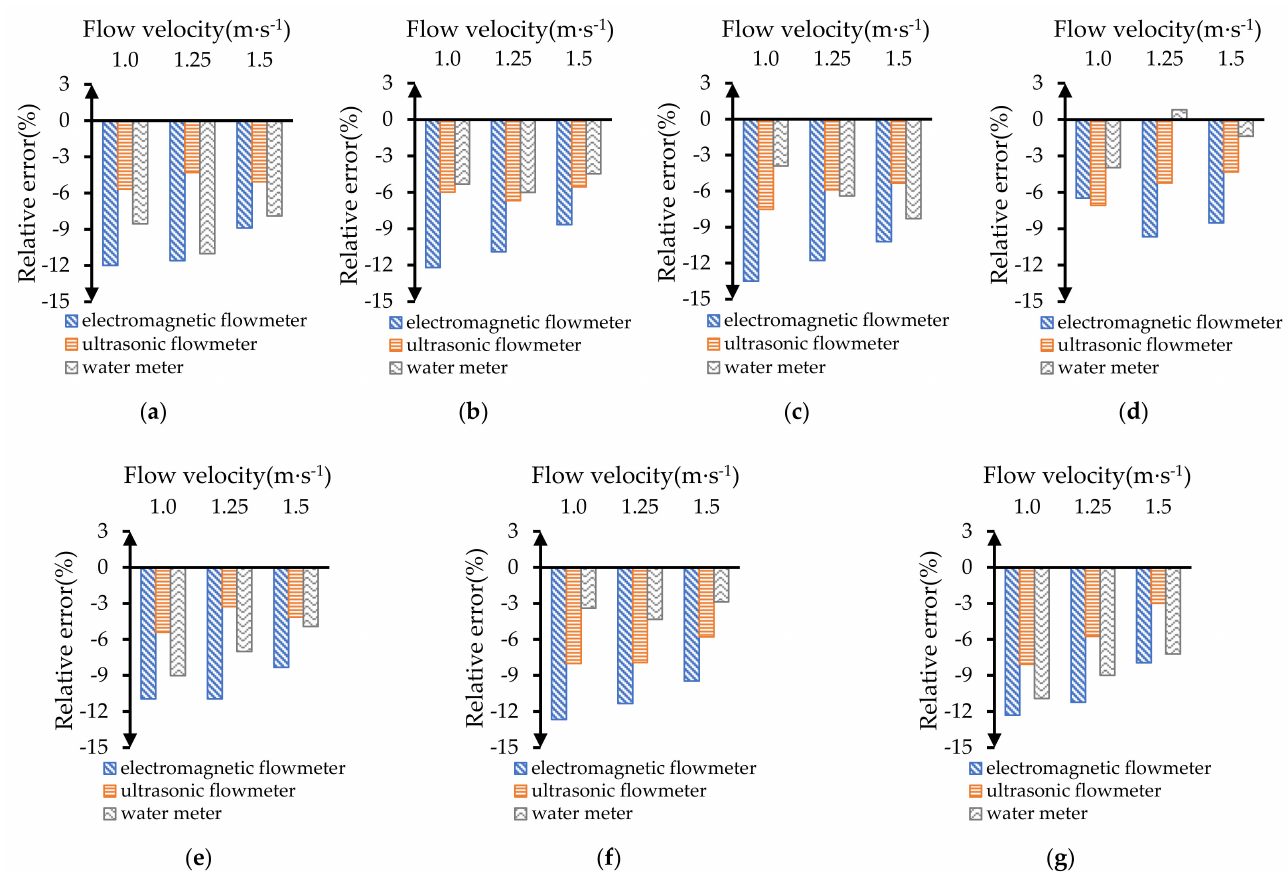
Figure 3. The relative error between each measuring device and the right triangle weir. ( a ) C0 sediment concentration; ( b ) C1 sediment concentration; ( c ) C2 sediment concentration; ( d ) C3 sediment concentration; ( e ) C4 sediment concentration; ( f ) C5 sediment concentration; ( g ) C6 sediment